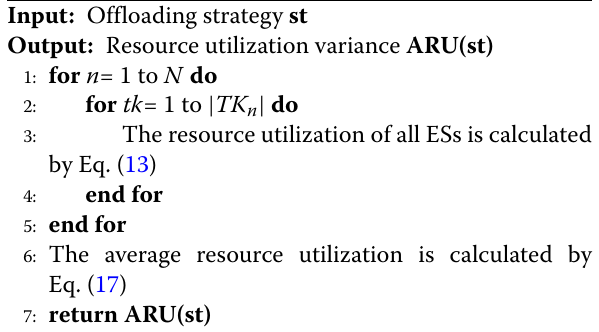
Algorithm 1 Time consumption calculation